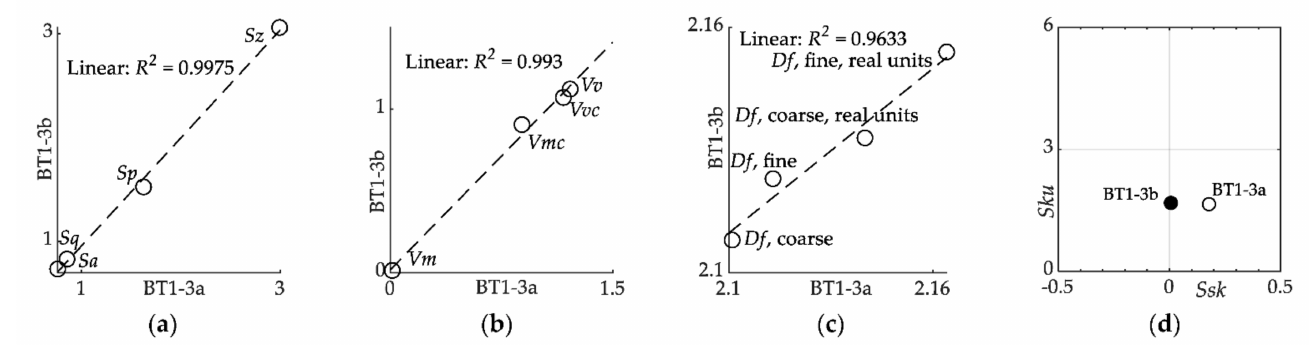
Figure 8. Relationship between surface parameters of both sides of the BT1-3 specimen: ( a ) height Sx ; ( b ) functional (volume) Vx parameters; ( c ) fractal dimension Df parameters; and ( d ) kurtosis Sku and skewness Ssk